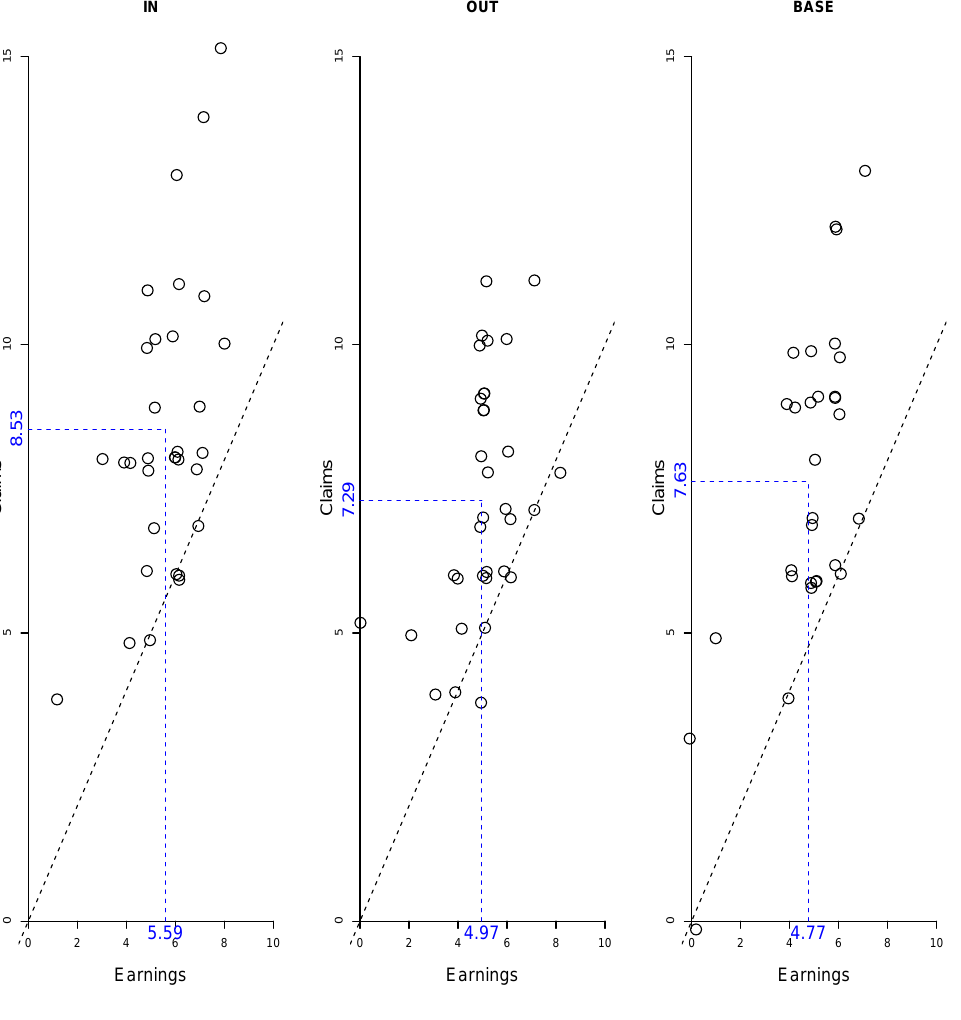
Figure 1. Dictators: contributions and claims. On the x -axis (earnings), the amount earned in the slider task. On the y -axis (claims), the amount claimed in the DG. Points above (below) the 45 ◦ line identify claims larger (smaller) than the amount contributed. Average values are reported along the axis. To improve visualization, a small random noise is added to the